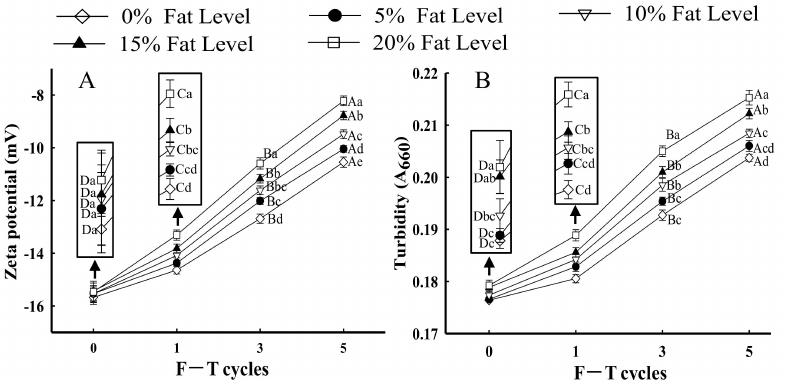
Figure 3. Influence of F–T cycles on zeta potential ( A ) and turbidity ( B ) of myofibrillar protein from quick-frozen patties with different fat levels. Values are given as the mean ± SE. The means for the same fat levels with different uppercase letters (A to D) and the same F–T cycles with different lowercase letters (a to e) differed significantly ( p <